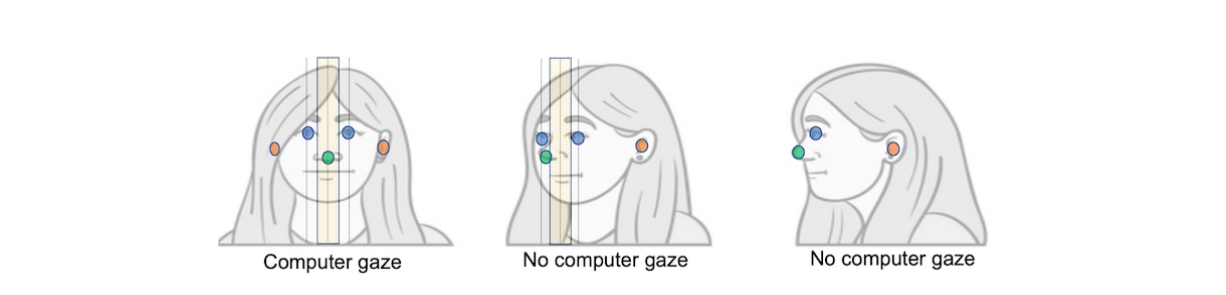
Figure 2. Classifying the doctor's computer screen gaze using face key point estimation.